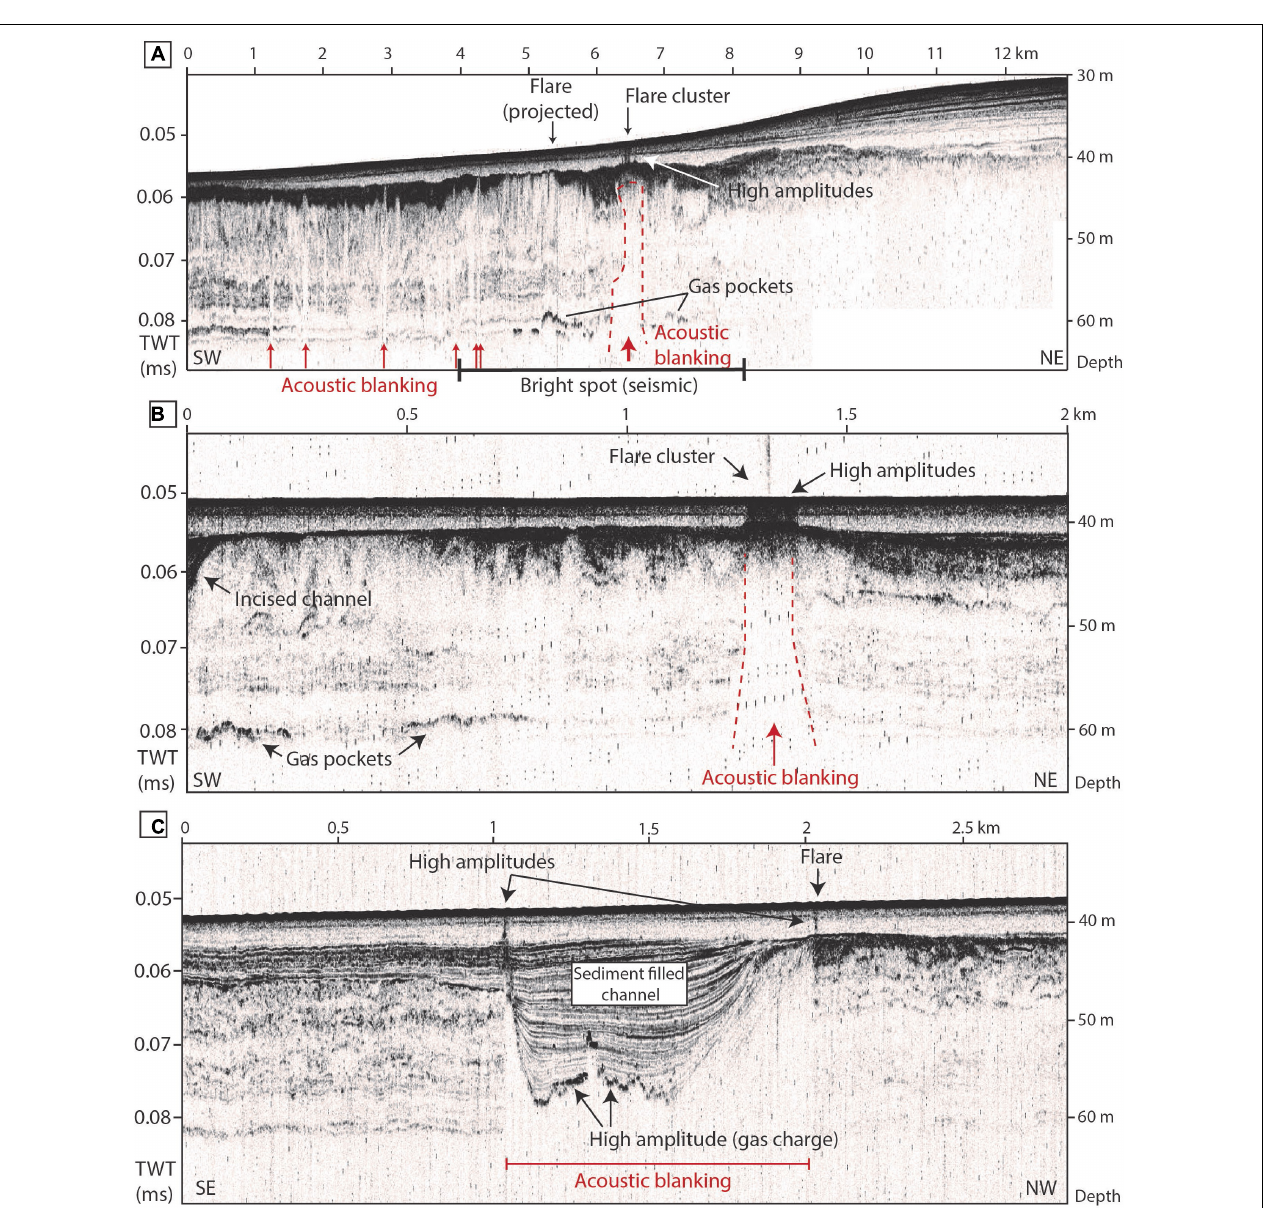
FIGURE 5 | Subbottom profiles recorded with the sediment echosounder Innomar SES-2000 during R/V Heincke cruise HE537 in the area close to salt diapir Berta. See Figure 6B for locations. Depth conversion has been estimated using a sound velocity of 1,500 m/s. (A) Profile covering the bright spot mapped in the deeper subsurface above salt diapir Berta. Acoustic blanking forming chimneys are indicated with red arrows, with the widest chimney below the flare cluster detected in the water column (red dashed line marks the outline). (B) Detailed profile focusing on the chimney (red dashed line), in which the high amplitudes between acoustic blanking and water column flare cluster becomes visible. (C) Detailed profile showing a sediment-filled channel with columnar acoustic blanking and high amplitude reflectors below, indicating increased gas concentrations migrating along the flanks of the channel up to the seafloor.